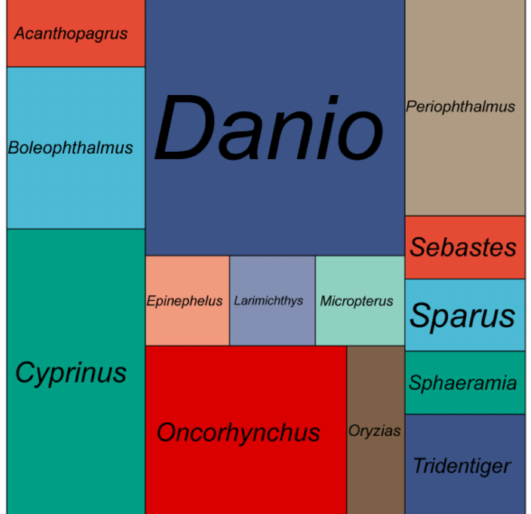
Figure 1. Mapping statistics of clean reads to the NT database. Area size represents the number of reads mapped to that